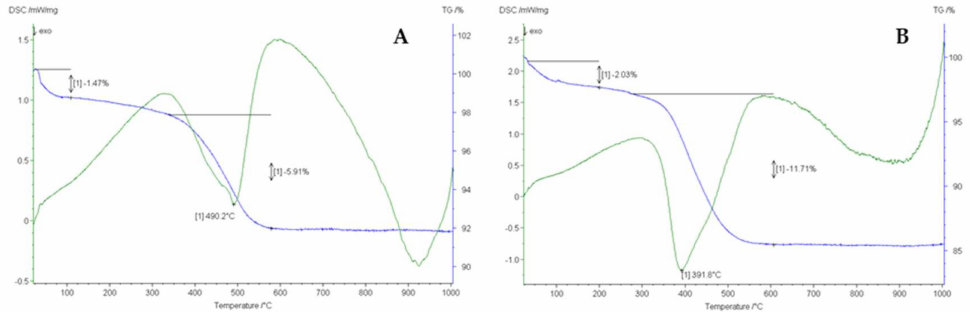
Figure 6. TGA (blue line) and DSC (green line) curves of TiO 2 @Oxisol ( A ) and n-TiO 2 @Oxisol ( B